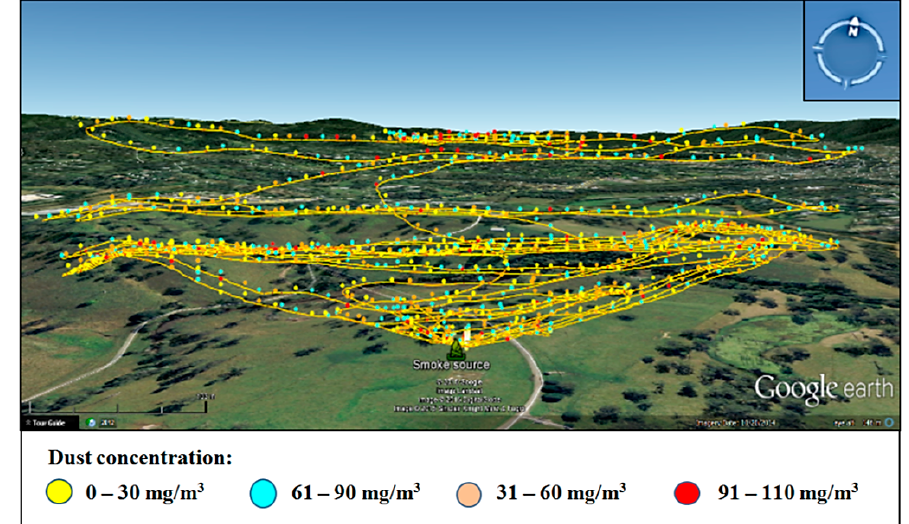
Figure 12. 3D visualization of the Test 1 data collected with Teklite- SHARP